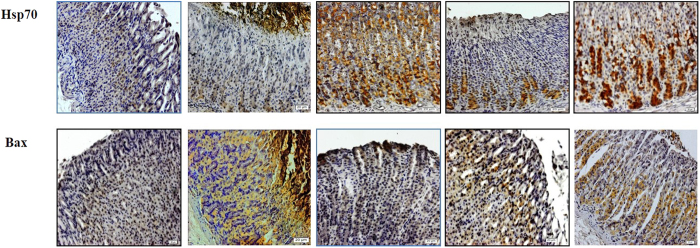
Effects MDLA on the immunohistochemistry analysis of expression of Hsp70 and Bax proteins in HCl/Ethanol induced gastric ulcer in rats.Normal control group (G1), ulcer control group (G2), omeprazole-treated group 20 mg/kg (G3), rats receiving 500 mg/kg of MDLA (G 4), and rats receiving 1000 mg/kg of MDLA (G5). Immunohistochemistry staining of Hsp70 shows over-expression of Hsp70 protein in the experimental groups (G3, G4 and G5). Meanwhile, Bax protein expression was downregulated in the experimental groups (G3, G4 and G5) (magnification 20×).